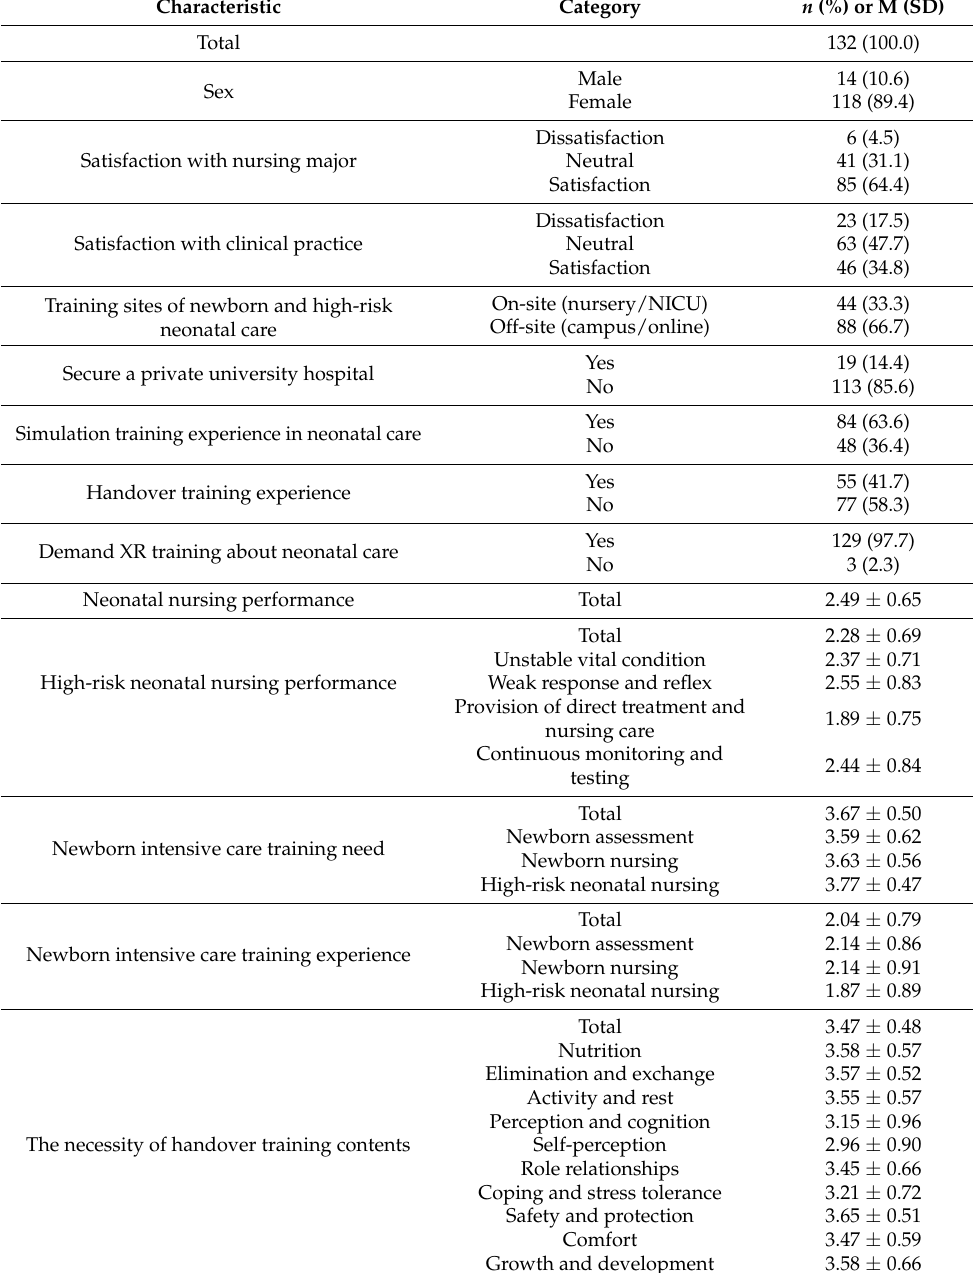
Table 1. General and neonatal nursing-related characteristics of participants ( n =